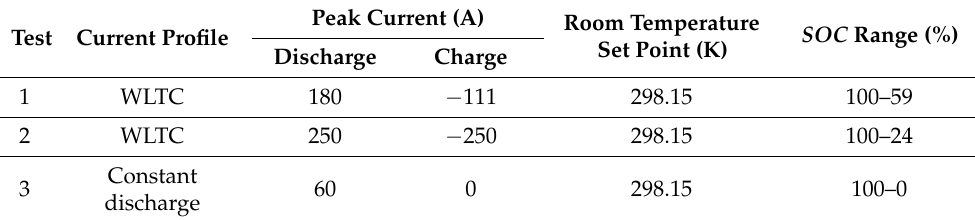
Table 5. List of validation